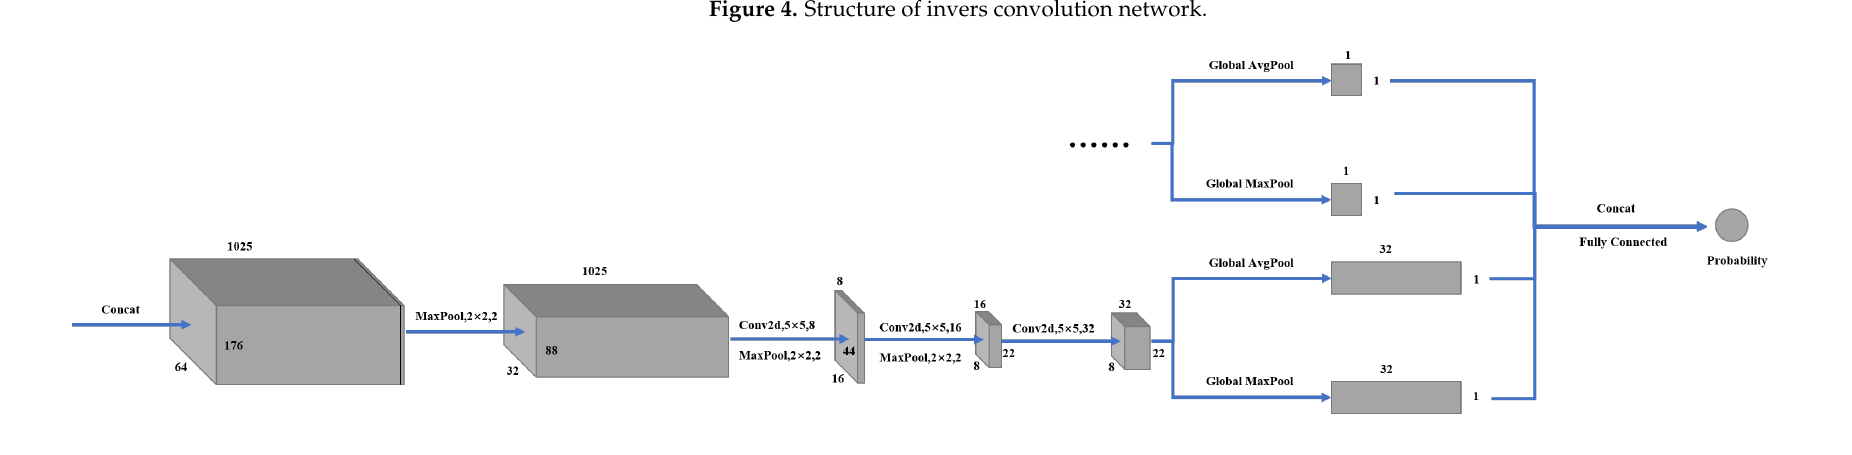
Figure 4. Structure of invers convolution network.